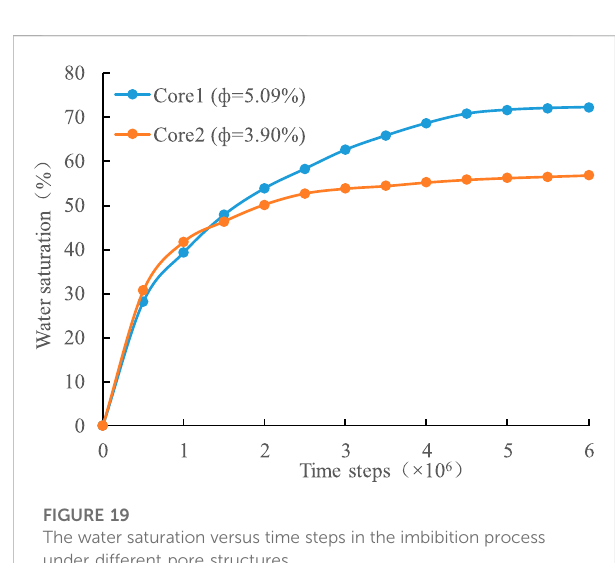
FIGURE 19 The water saturation versus time steps in the imbibition process under different pore